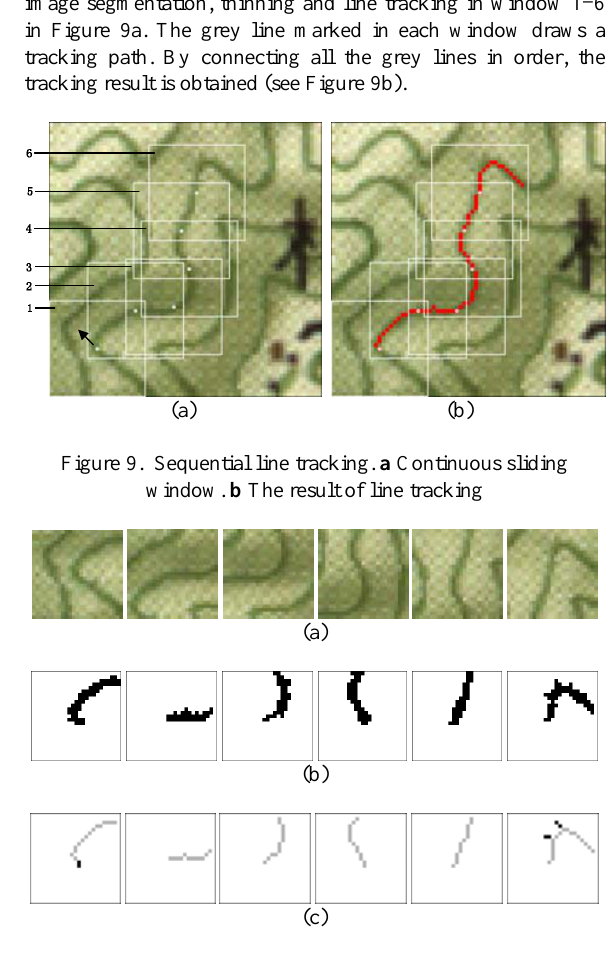
Figure 10. a Images in window 1-6 in Figure 9a. b Corresponding segmentation results of current linear feature. c Corresponding results of thinning and line tracking